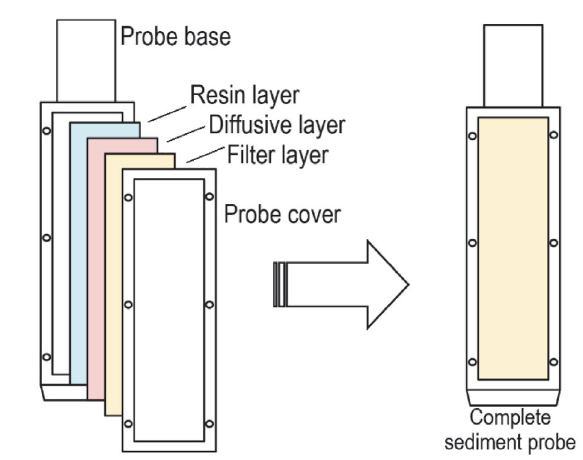
Figure 1. The components and assembled DGT probe for sediment